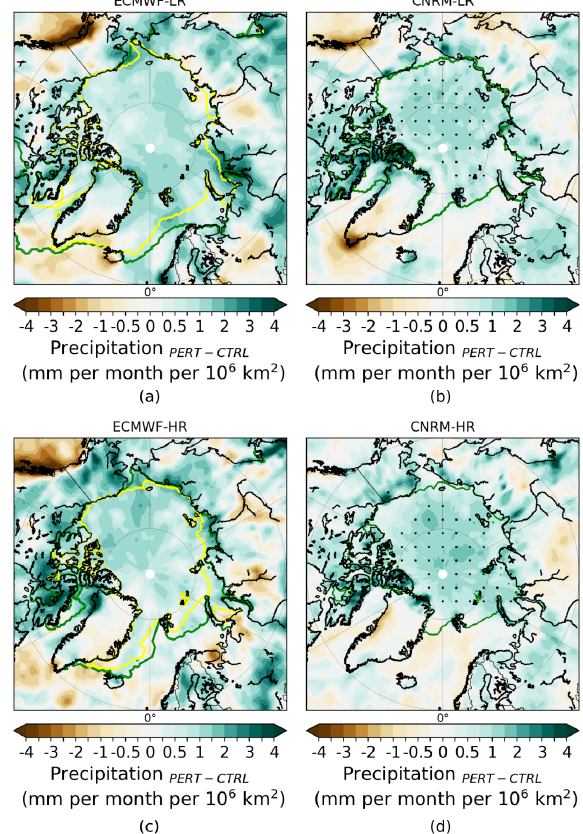
Figure 9. Ensemble mean changes (PERT − CTRL) in summer (JAS) precipitation scaled by the amount of sea ice extent loss for ECMWF-LR (a) , CNRM-LR (b) , ECMWF-HR (c) and CNRM- HR (d) . The dots show where the response is statistically significant according to a 10% level FDR test associated with a Kolmogorov– Smirnov test. The green and yellow lines represent the sea ice edge (15% ice concentration) from CTRL and PERT,